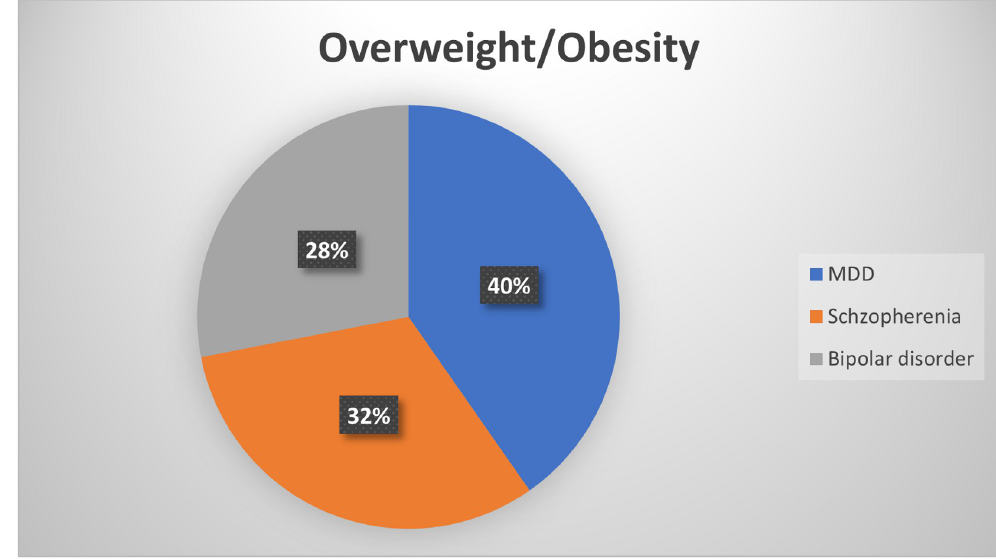
Fig 2. The Burden of overweight/ obesity among different psychiatric disorders Dire Dawa, Eastern Ethiopia, 2021.